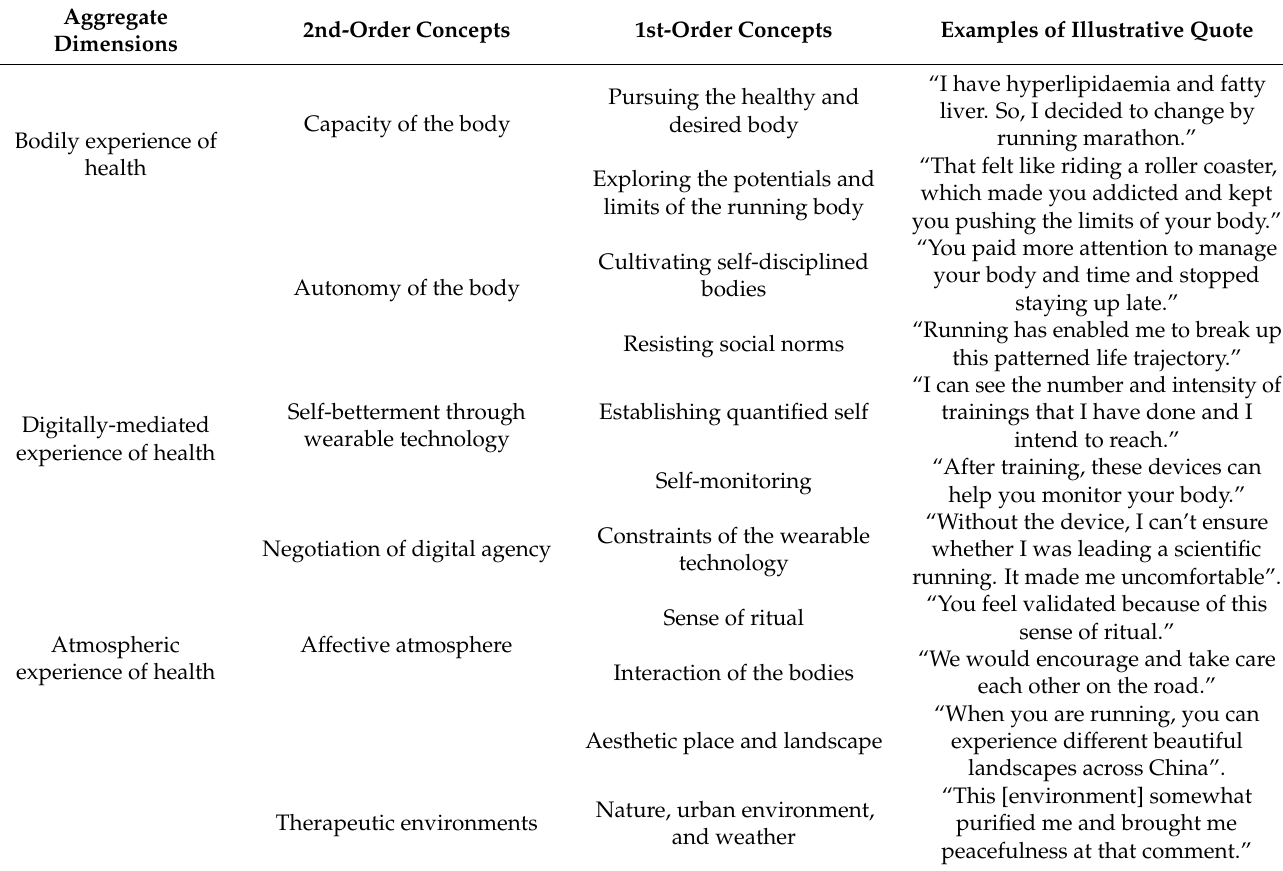
Table 2. The data coding of marathon